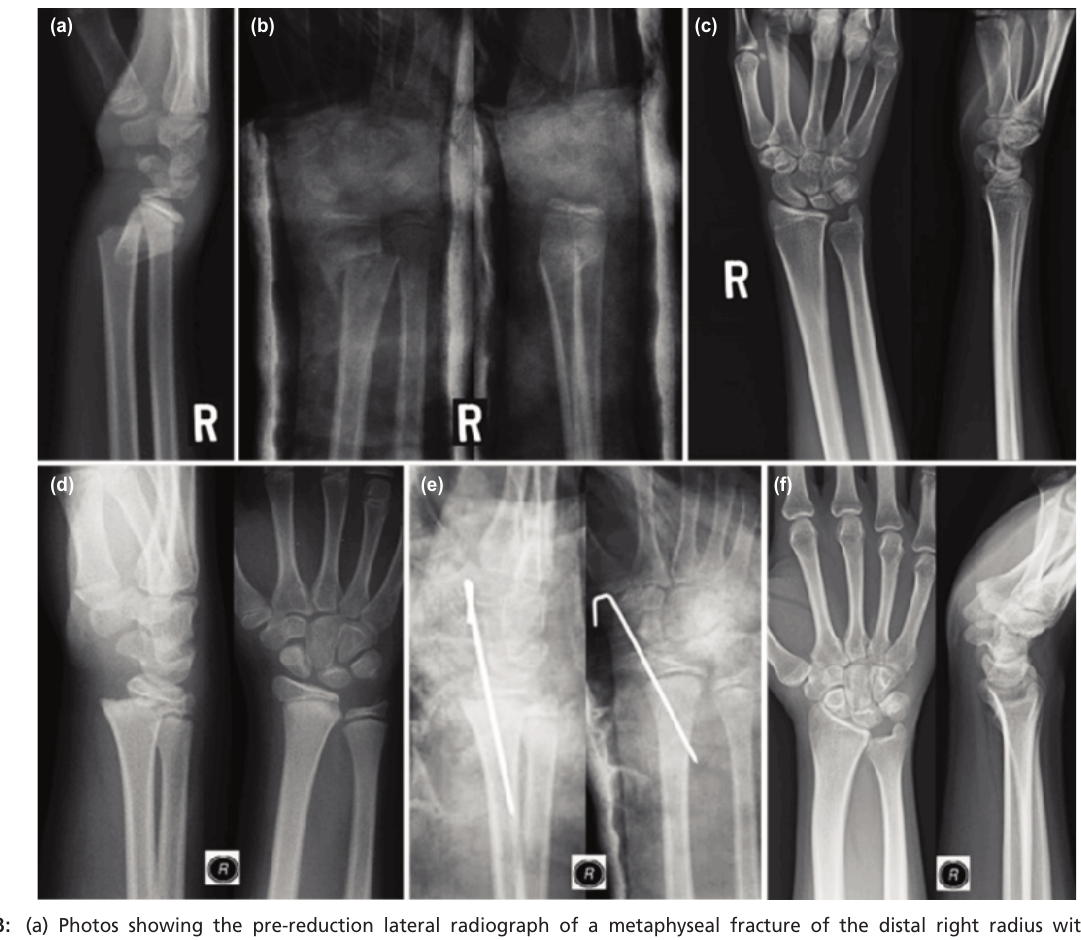
(a) Photos showing the pre-reduction lateral radiograph of a metaphyseal fracture of the distal right radius with dorsal Fig. 3: angulation about 45° in a 13-year-old boy, (b) immediate reduction of the fracture followed by a cast application improved the dorsal angulation on lateral radiograph and showed good bone contact on AP view, (c) good remodeling and bone union as seen at skeletal maturity, (d) distal physeal fracture of the right radius on a different child who was a 12-year-old boy with dorsal translation and dorsal tilt of the epiphysis, (e) closed reduction and percutaneous smooth K wire corrected the displacement and secured the reduction, (f) and finally AP and lateral radiographs at skeletal maturity revealed complete healing of the fracture without evidence of physeal